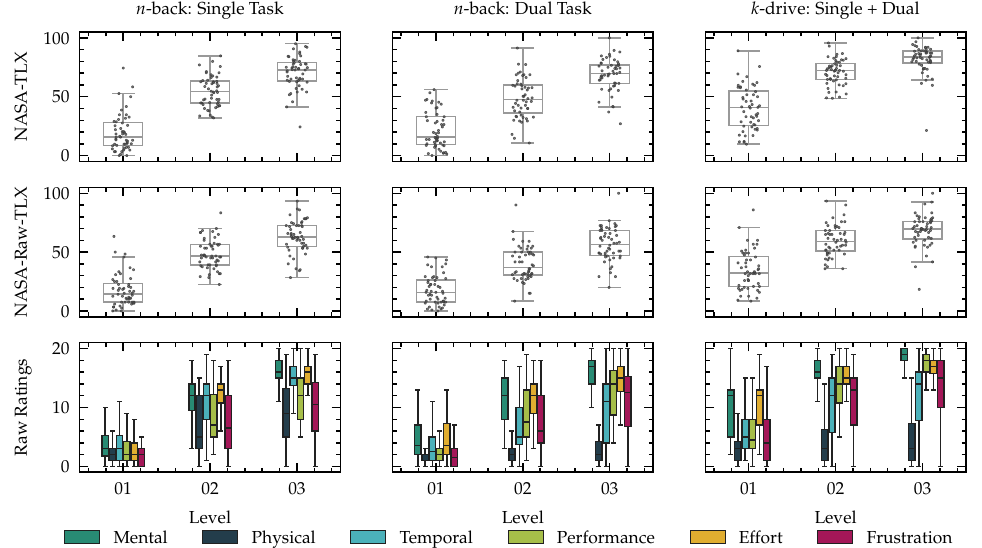
Figure 10. Results of subjective feedback for n -back and k -drive tests of increasing intensities of cognitive load. The first row shows the weighted NASA-TLX ratings during visual-only stimuli n -back, audiovisual n -back stimuli and single-task-only 1-drive and dual-task 2-drive and 3-drive tests. The second row shows the unweighted raw-TLX scores. The last row visualized the raw rating for every of the six NASA-TLX